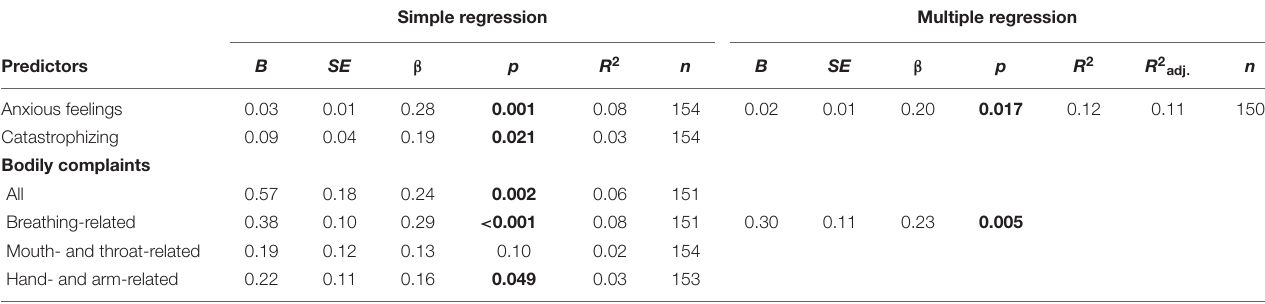
TABLE 8 | Results of the linear regression analyses for MPA components as predictors of self-rated change in performance quality from practice to public performance. Simple regression Multiple